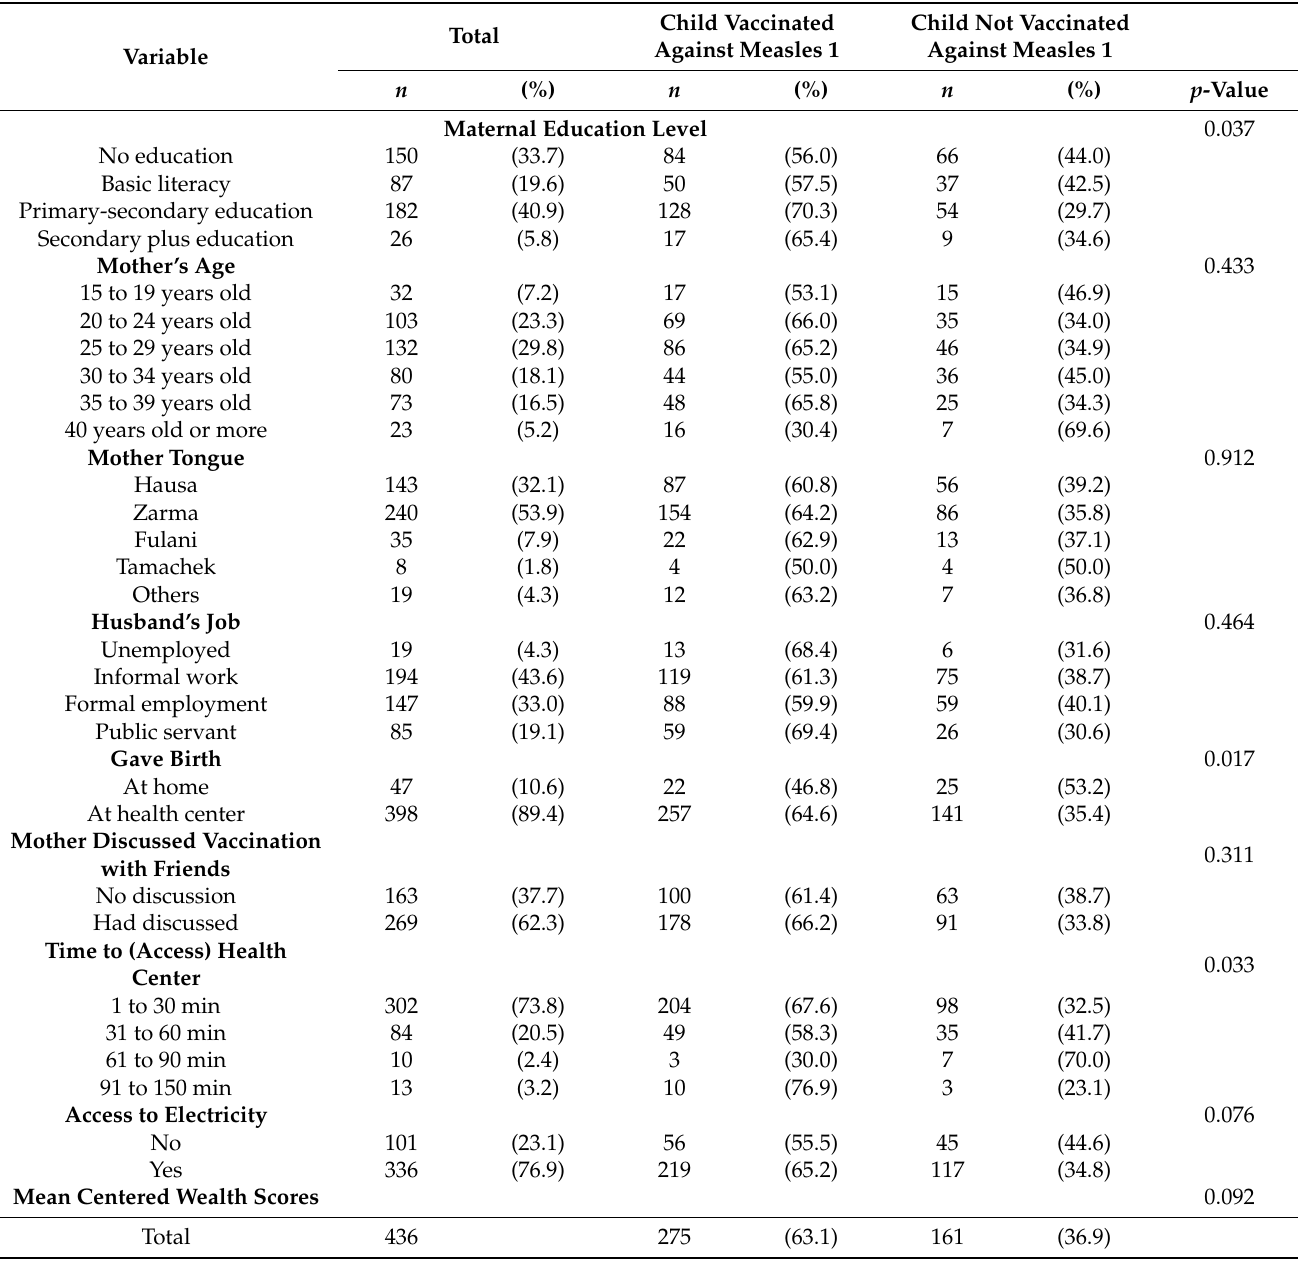
Table 1. Study population